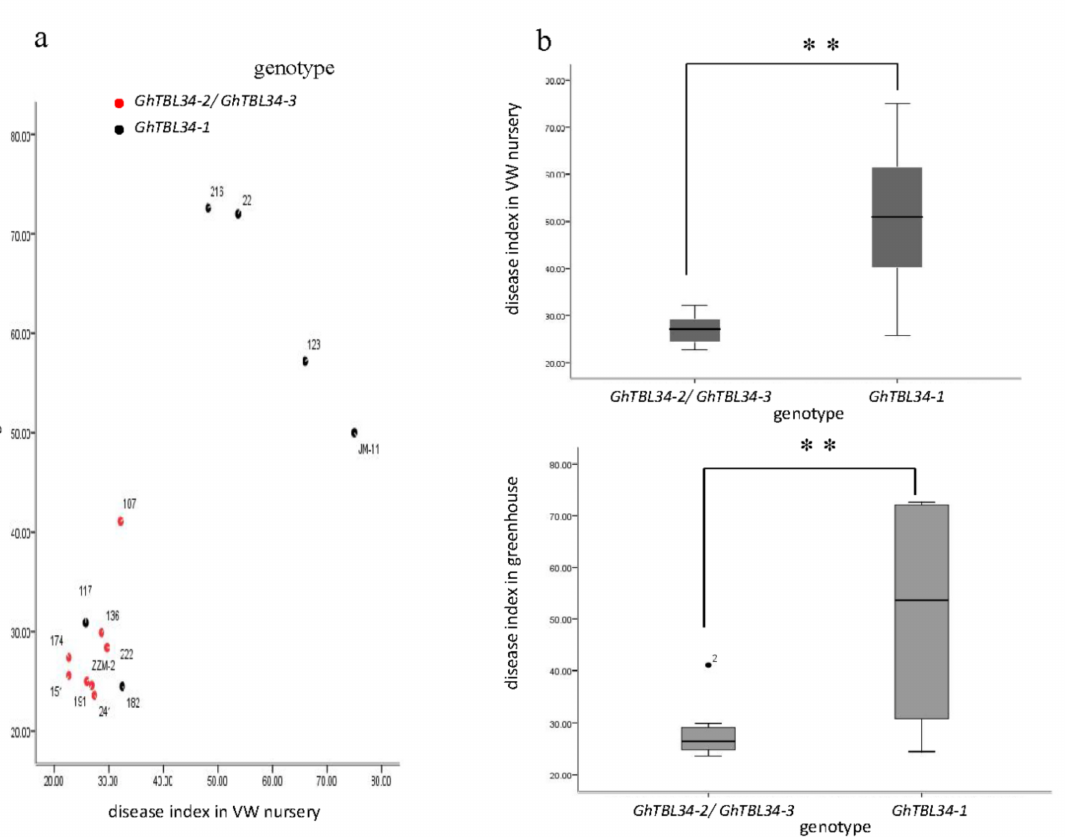
Figure 3. Scatter plot of the distribution of the three alleles in different anti-susceptibility materials ( a ) and the difference of the average disease index in different environments ( b ). Note: Both of GhTBL34-2 and GhTBL34-3 genotypes